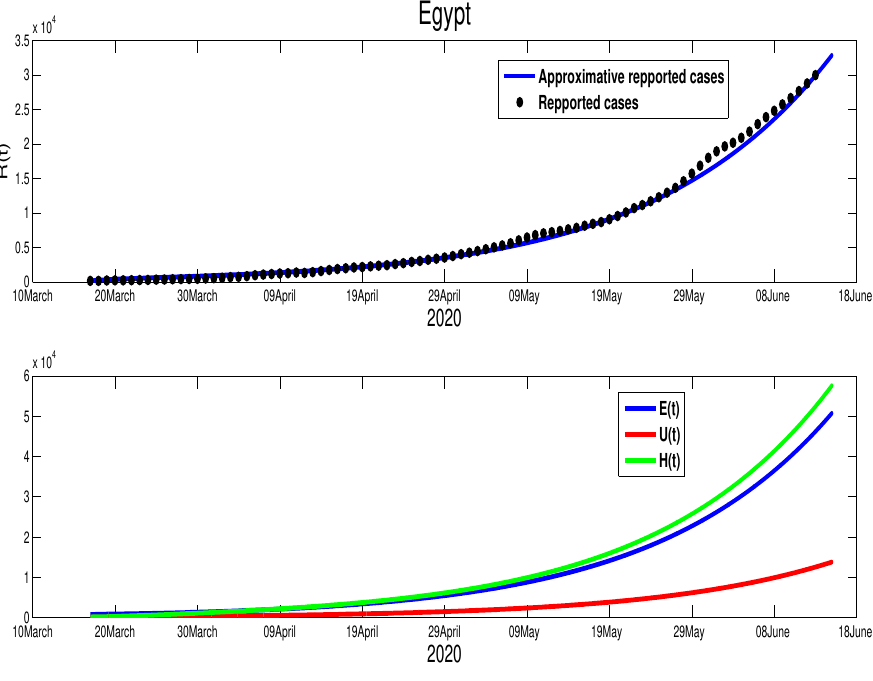
Figure 2. The fitting of data of active COVID-19 cases in Egypt and corresponding times series of the other